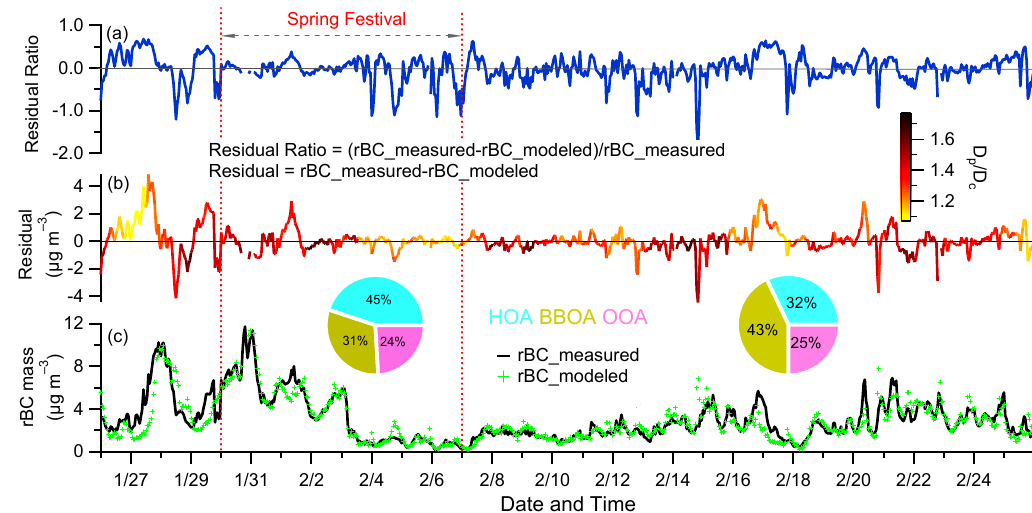
Figure 7. Linear fit between measured and modeled rBC. Table 1. The tri-linear regression results for the rBC-ACSM-PMF attribution.